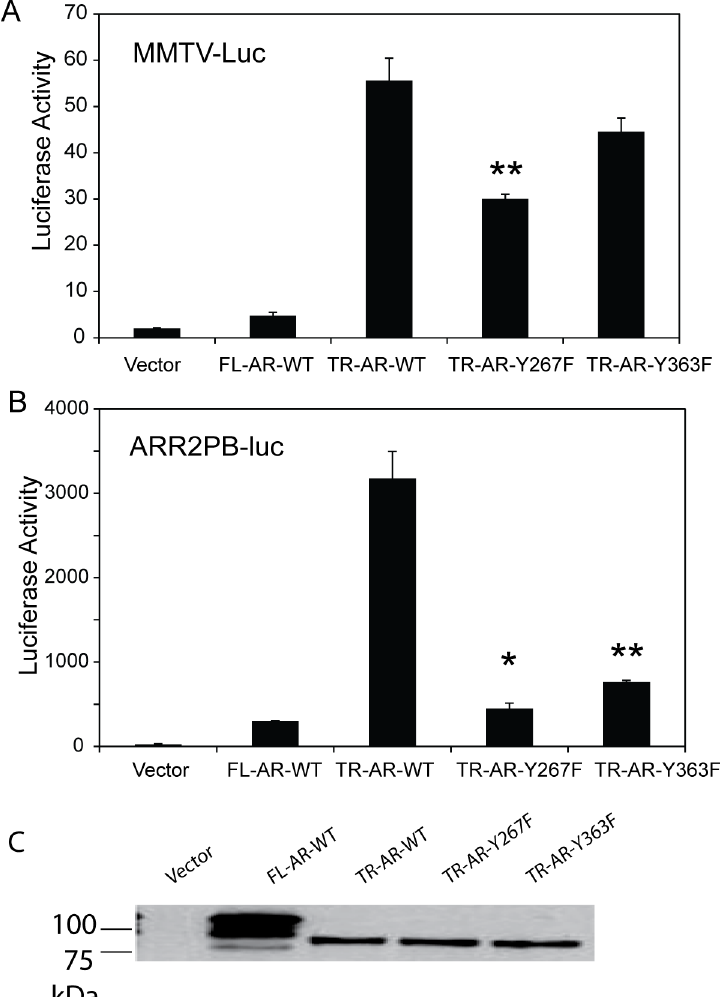
Fig 1. Phosphorylation site mutants of constitutively active truncated AR lacking the ligand-binding domain exhibit impaired transcriptional function in reporter assays. (A, B) LNCaP cells were transiently transfected with vector alone or the expression vector encoding full-length AR wt, truncated AR wt (TR-AR-WT), Y267F or Y363F mutants of truncated AR along with the AR-dependent reporter MMTV- luciferase (A) or ARR2-PB-luciferase (B). After 48 hours in androgen depleted media, luciferase activity was determined from cell lysates. Data shown with the mean + standard deviation of triplicate samples are representative of three independent experiments with similar results. * , p < 0.001 vs TR-AR-WT; ** , p < 0.05 vs TR-AR-WT by two-group t-test adjusted using the Bonferroni method. (C) Cell lysates of COS-7 cells transiently transfected with respective AR constructs were immunoblotted with the monoclonal antibody against